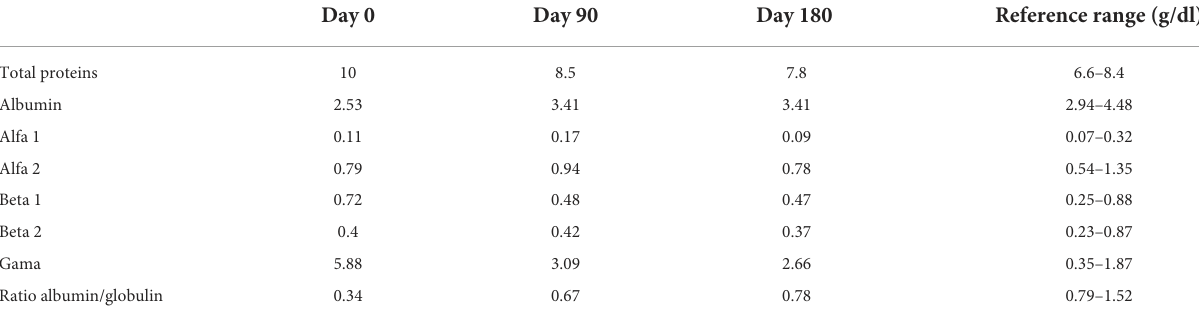
TABLE 1 Proteinogram values registered at day 0, 90 and